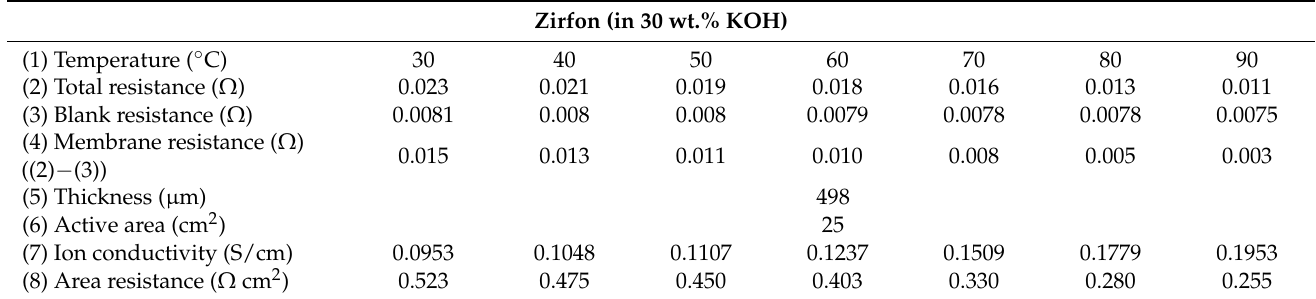
Figure 7. Nyquist plot via the zero gap cell in 30 wt.% KOH solution at 30 ◦ C ( a ) with membrane, ( b ) without membrane. Table 1. Electrochemical properties via zero gap